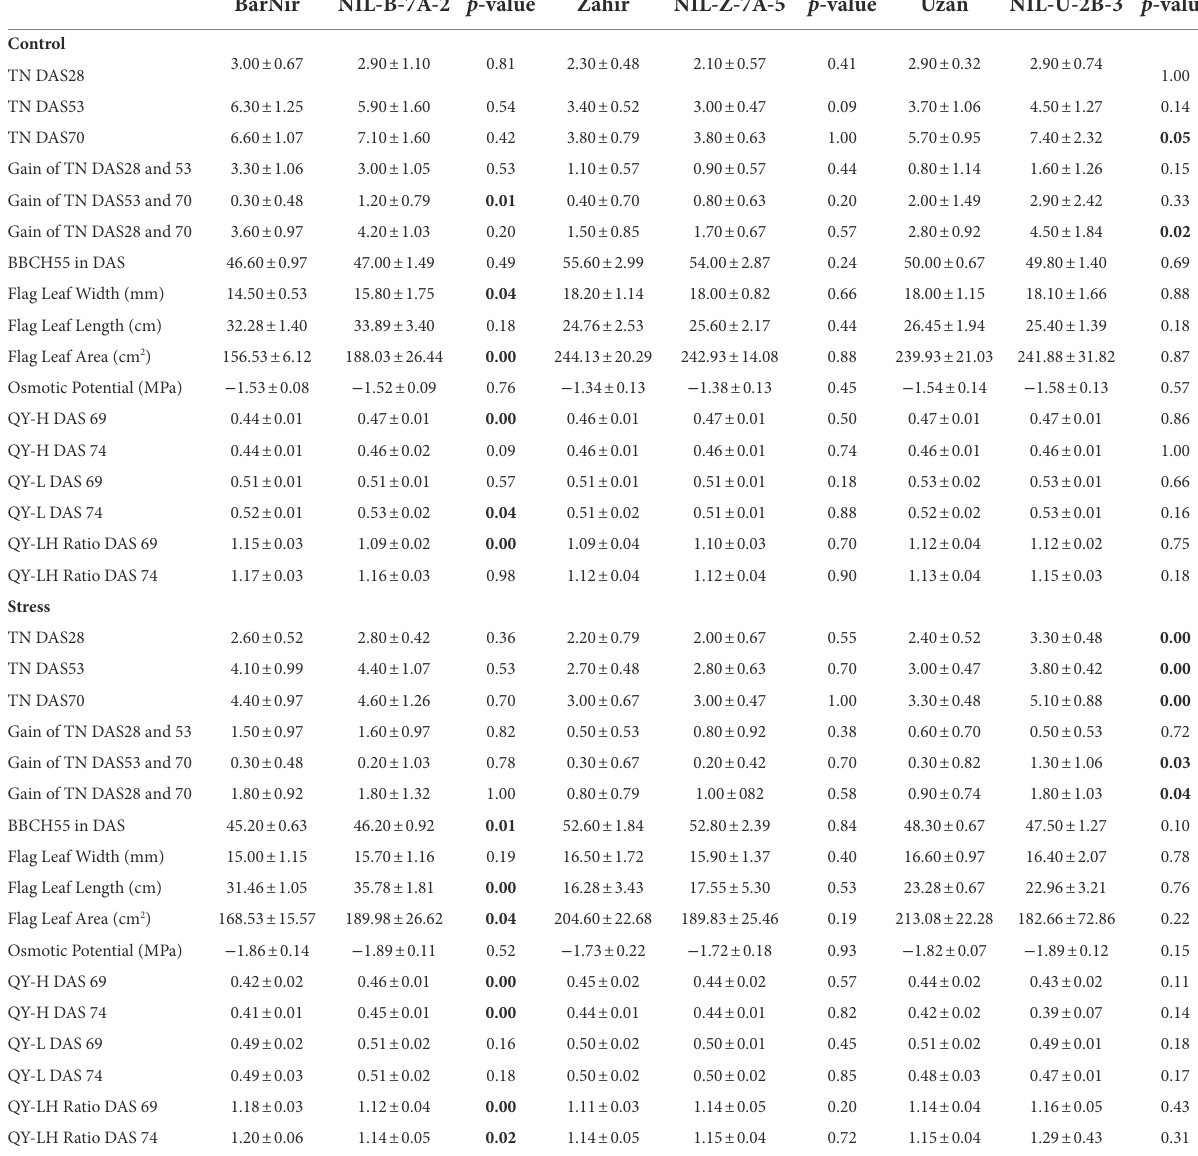
TABLE 3 Averages and standard deviation and significant differences ( t -test) between parents and corresponding NIL of traits measured before